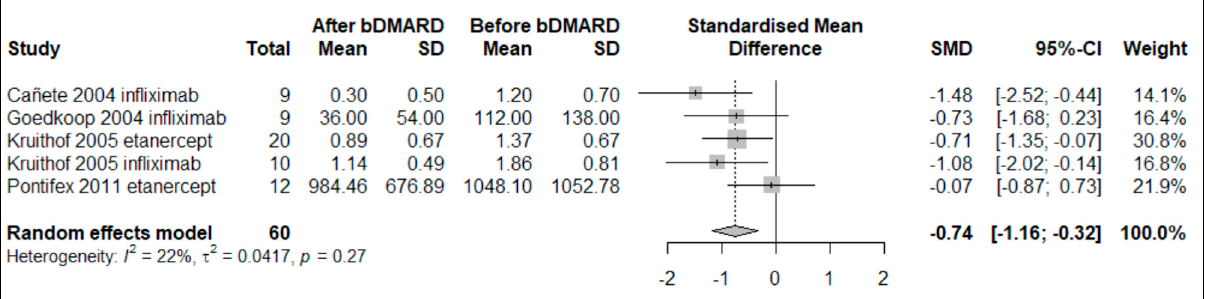
Figure 2. Forest plot of standardized mean difference of CD3+ lymphocytes in synovial tissue of PsA patients treated with bDMARDs. Negative effect means reduction in CD3+ lymphocyte level. Abbreviations: bDMARD: biological disease-modifying anti-rheumatic drug, SD: standard devia-